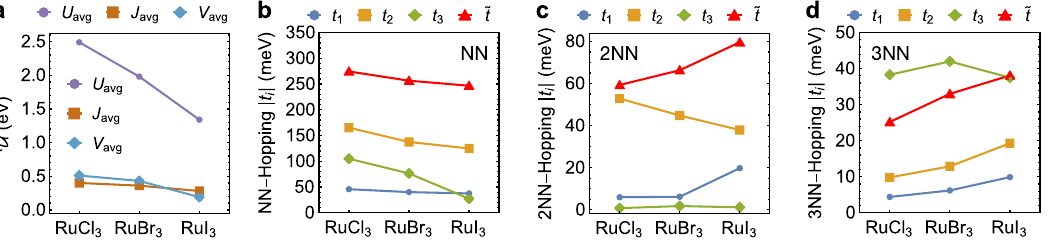
Fig. 4 Ab-initio-computed multi-orbital Hubbard model parameters across the RuX 3 family. a cRPA results for the orbitally averaged on-site Hubbard interaction ( U avg ), Hund's coupling ( J avg ), and the nearest-neighbor V avg coupling. b Absolute magnitude of hopping parameters